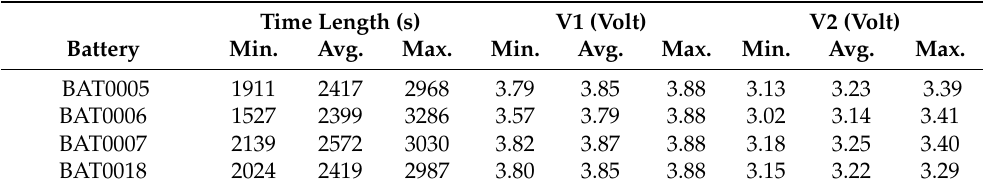
Table 3. Values of normal usage phase time distribution. Time Length (s) V1 (Volt) V2 (Volt) Battery Min. Avg. Max. Min. Avg. Max. Min. Avg.